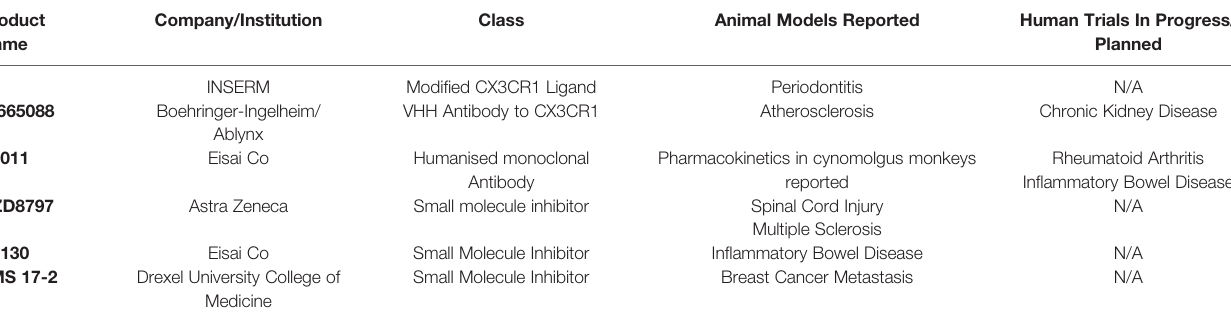
TABLE 2 | Pharmacological agents targeting the CX3CL1-CX3CR1 axis currently reported to be in development or clinical trials and disease of interest.